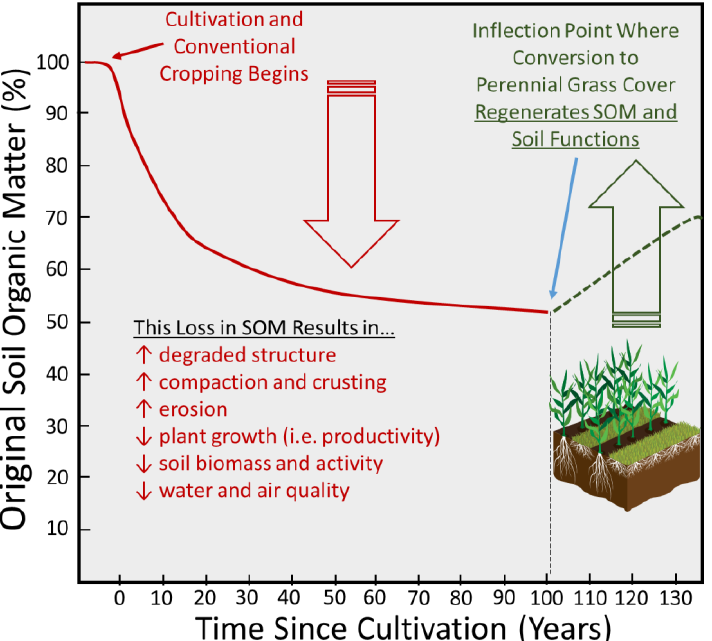
Figure 4. A conceptual diagram illustrating how loss of soil organic matter leads to soil degradation with ultimate outcomes of reduced productivity and increased potential for water quality impairment. PGC systems will increase soil organic matter and regenerate the productive capacity of the soil. (Adapted from Weil & Brady [66]).